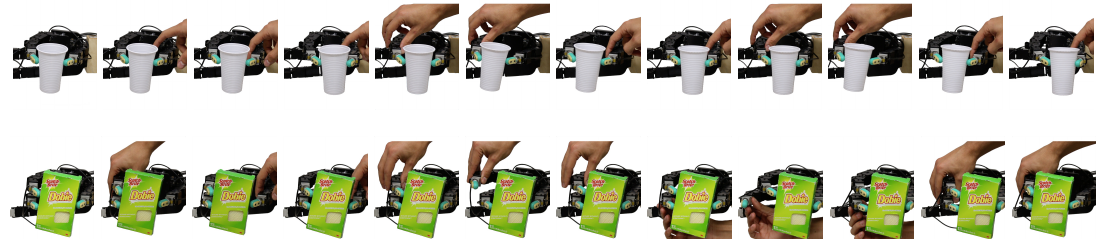
Figure 7. Experiments showcasing master–slave operation where the fingers stabilize the object despite one finger introducing perturbations to change the object’s positions in-hand. The experiment showcases how the independent finger grip stabilization controllers, paired with upper level control policies, can enable in-hand object manipulation. Instead of an upper level controller, finger perturbations were introduced by a human experimenter for a two-finger grasp (upper row) and a three-finger grasp (lower row). In addition, in the three-finger grasp we show that fingers can be removed from the object while it is re-stabilized by the remaining fingers.